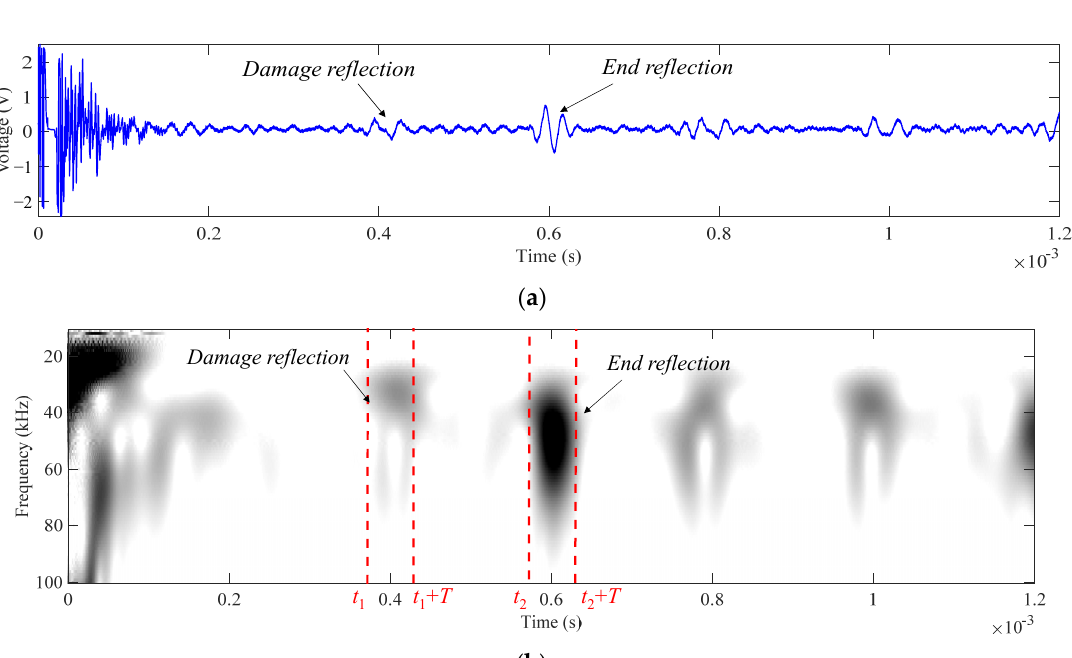
Figure 11. ( a ) The received signal and ( b ) its complex Morlet wavelet transform result for the first damage case.